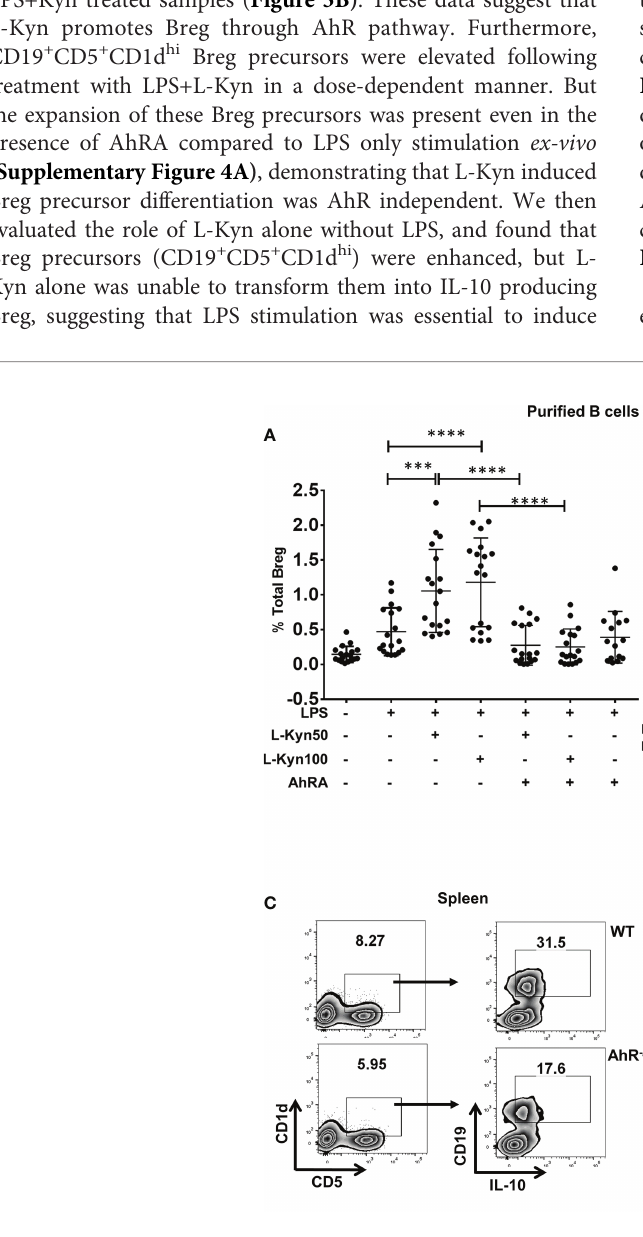
FIGURE 3 | Trp metabolite L-Kyn promoted Breg differentiation through AhR pathway. CD19 + B cells were negatively selected from whole splenocytes of WT mice, disaggregated and seeded with LPS (10 m g/ml), increasing concentrations of L-Kyn (50µM and 100 m M) and LPS + L-Kyn + CH 223191(10 m M) an aryl hydrocarbon receptor antagonist (AhRA) for 72 hrs. Bregs were identi fi ed as CD19 + CD5 + CD1d hi IL-10 + by fl ow cytometry. (A) Total percentage of Bregs (CD19 + CD5 + CD1d hi IL- 10 + ) in ex-vivo experiments performed with negatively selected puri fi ed B cells following stimulation with no LPS, LPS, LPS+L-Kyn, LPS+AhRA+L-Kyn, and LPS+ AhRA. Data shown here are pooled from six independent experiments with 3 technical replicates in each condition. (B) IL-10 levels in the media collected from above described experiments. (C) Representative fi gure of FACS analyses of splenic tissue con fi rmed the reduction of Breg (CD19 + CD5 + CD1d hi IL-10 + ) in tumor- bearing AhR -/- on day 9 post tumor implant. (D) Total percentage of Bregs (CD19 + CD5 + CD1d hi IL-10 + ) in spleens of tumor-bearing WT and AhR -/- mice on Day 9 post tumor implant (n = 4-6 mice per group). *p < 0.05, **p < 0.001, ***p < 0.0001, ****p <